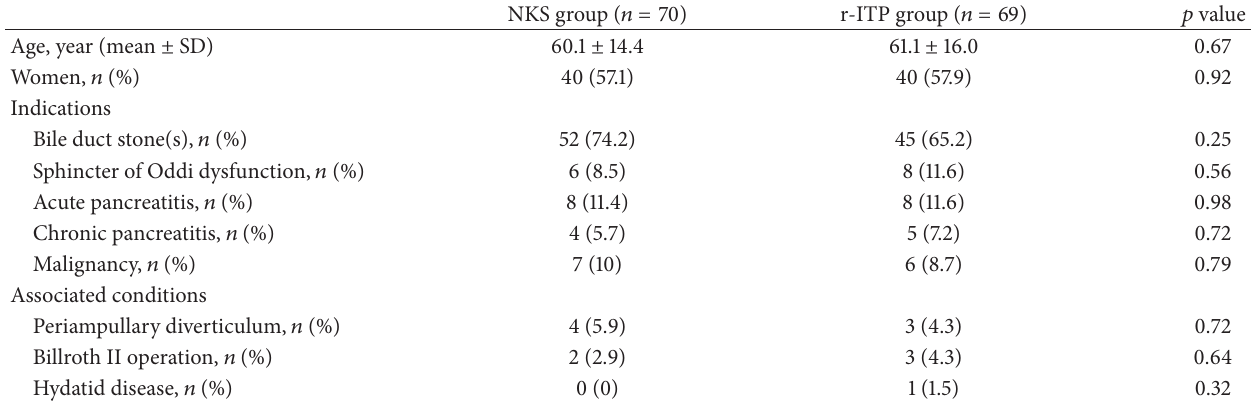
Table 1: Baseline demographic and clinical characteristics of eligible patients.